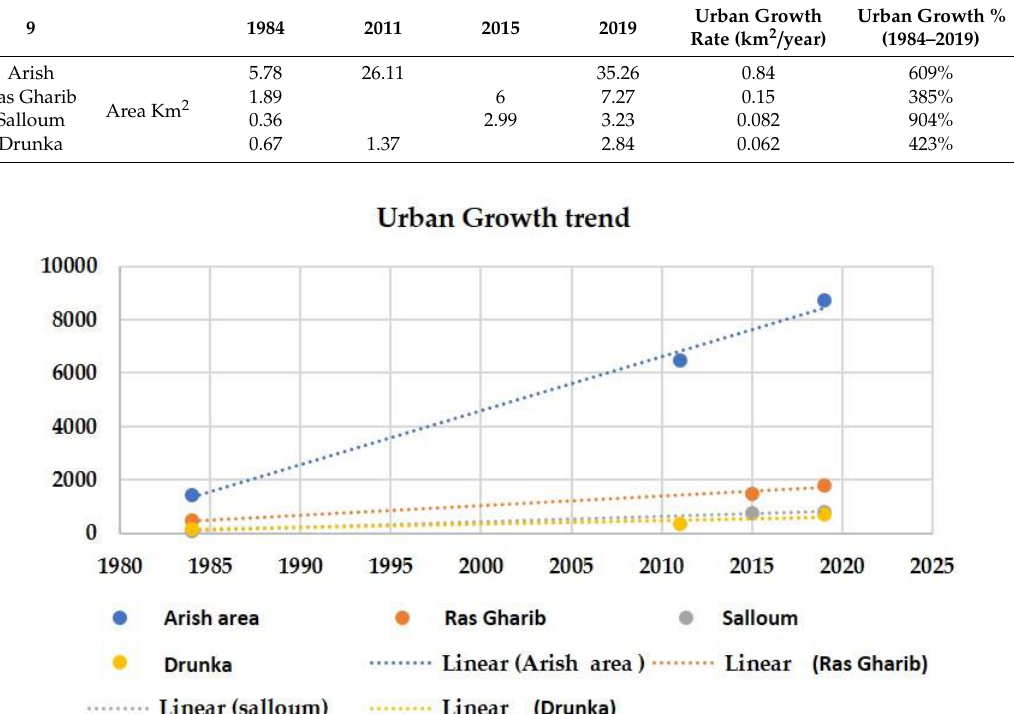
Table 2. The urban growth changes over the time from 1984 to 2019.